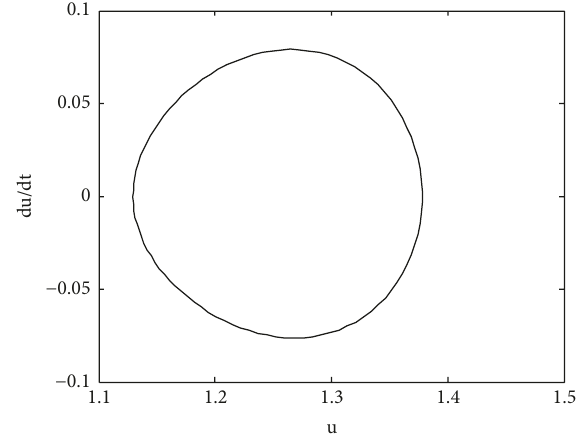
Figure 10: Phase diagram of meshing